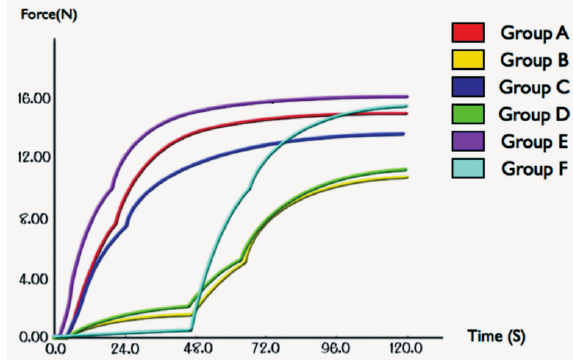
Figure 2- Shrinkage strain resulting from polymerization contraction of the experimental